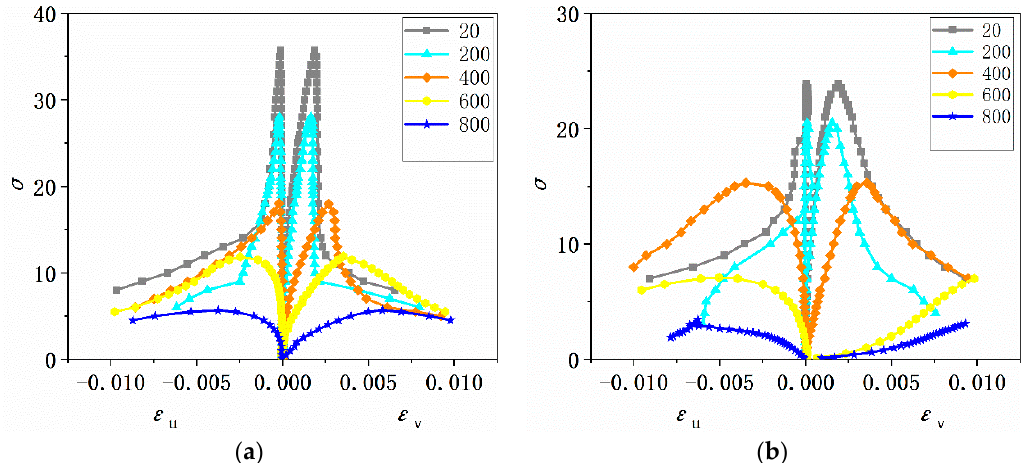
Figure 13. Stress–strain curve of specimens after high temperature: ( a ) SAC, ( b ) NC. Figure 13. stress-strain curve of specimens after high temperature: ( a ) SAC, ( b )